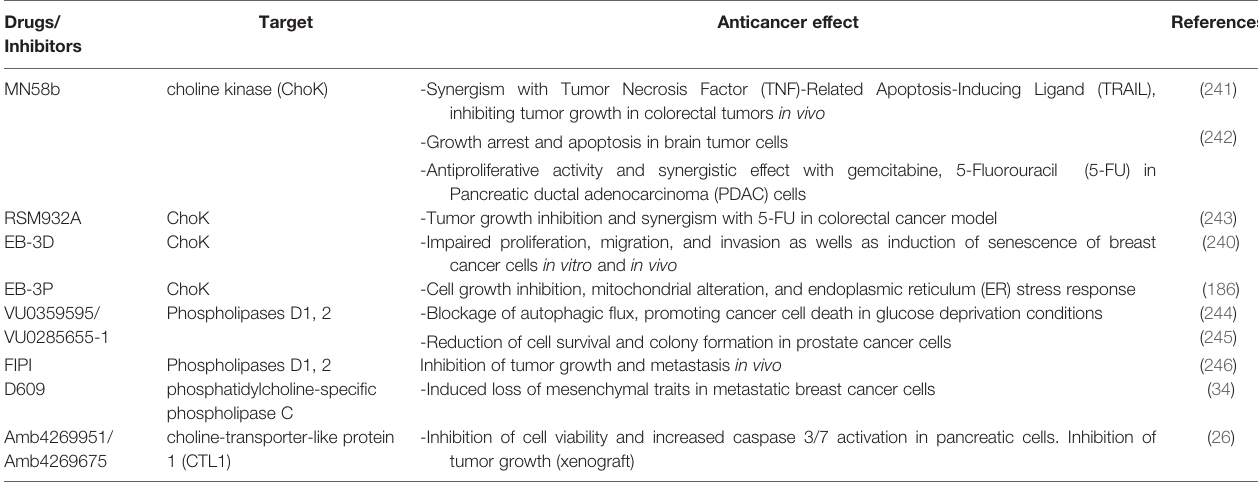
TABLE 1 | Targeting PtdCho metabolism — current strategies for experimental cancer control and treatment. Drugs/